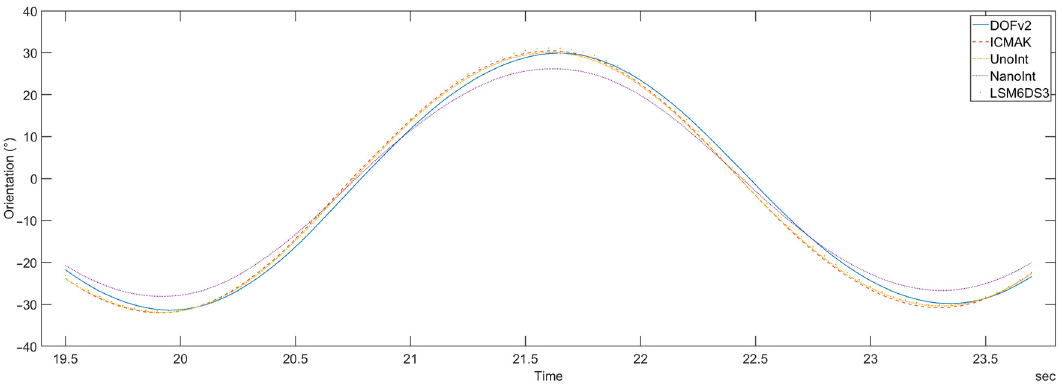
Figure 19. One period of calculated orientation for all five DIY sensors.